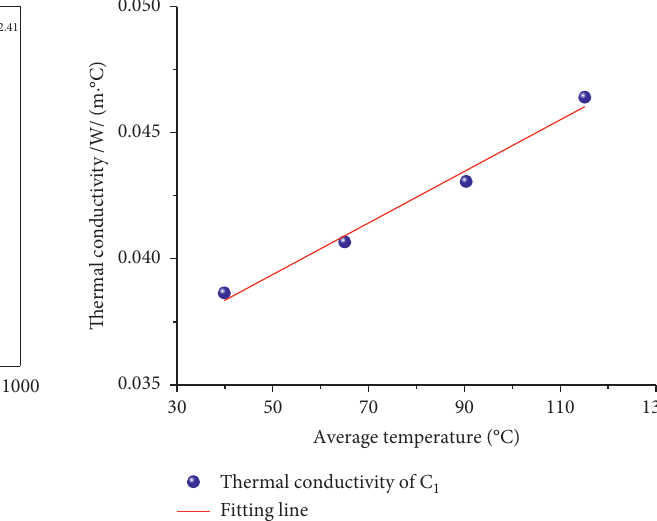
Figure 15: Effective test results of the passive thermal insulation material.